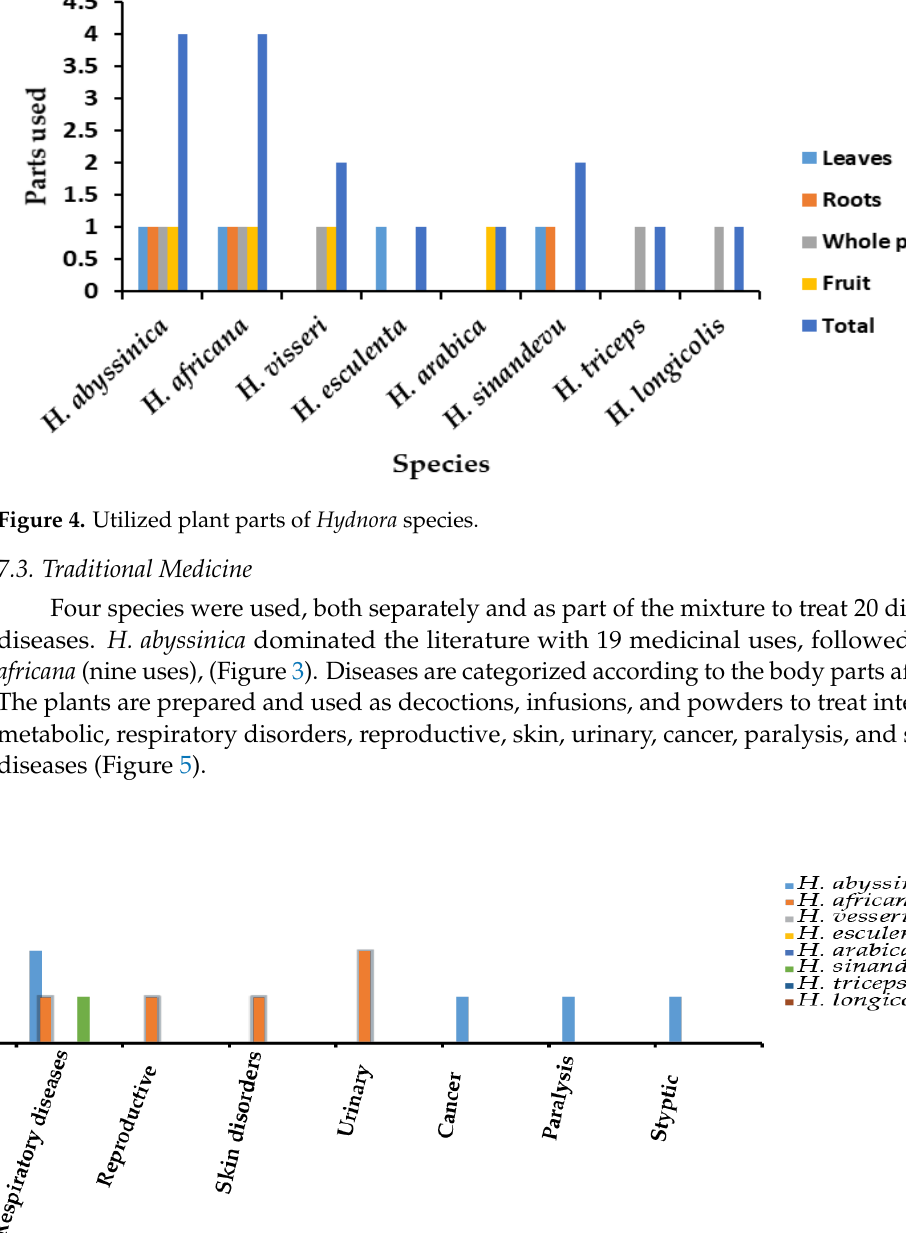
Figure 5. Diseases treated using Hydnora species in Africa and the Arabian Peninsula .